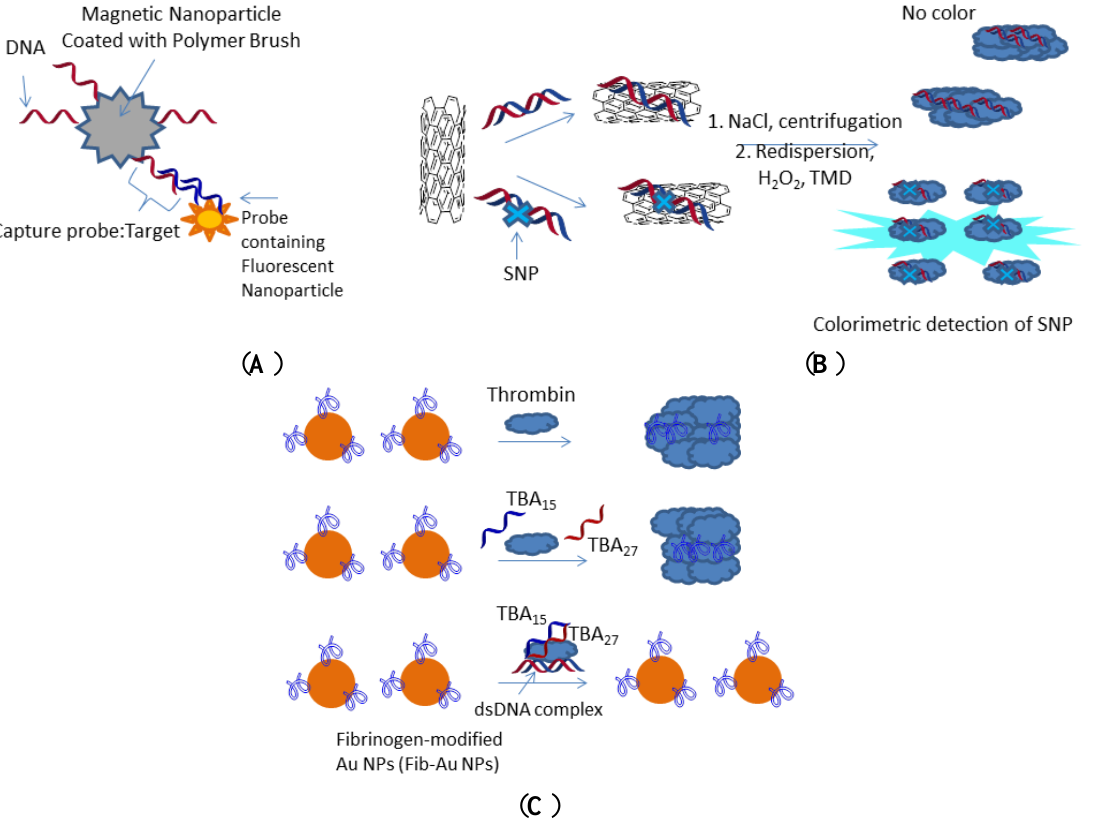
Figure 4. Representative optical methods for enzyme-free detection of SNPs: Oligo ethylene glycol mecrylate (OEGMA)-coated magnetic nanoparticle detecting herpes simplex (HSV) target [44] ( A ); single-walled carbon nanotube (SWNT) intrinsic peroxidase-like activity in presence of fully complementary and single-mismatched DNA duplex [45]; double-stranded DNA (dsDNA) containing a mismatch inhibit salt-induced aggregation of SWNTs, whereas SWNTs in solution with fully complementary dsDNA are easily precipitated in presence of salt. The precipitate can be collected, re-dispersed in a buffer and analyzed by a color reaction in the presence of 3,3,5,5,-tetramethylbenzidine (TMB) and H O ( B ); a colorimetric detection assay using bivalent thrombin-binding 2 2 aptamers (TBA) and fibrinogen-conjugated Au-nps to detect DNA based on controlled thrombin activity [50] ( C